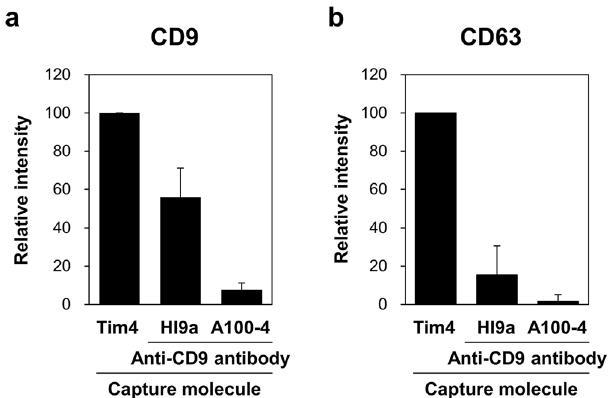
Figure 1. Comparison of the capture efficiency of EVs from serum between Tim4- and anti-CD9 antibody- based methods. Serum of normal donors (n = 6, 50 µL) was applied to a well of 96-well plate coated with Tim4 or anti-CD9 antibody (HI9a or A100-4). After washing, ALP-labeled antibody against an exosomal surface marker CD9 ( a ) or CD63 ( b ) was added to the well, followed by detection of chemiluminescence in the presence of ALP substrate. The signal intensity is expressed as a ratio to that obtained with Tim4. Data are shown by mean ±